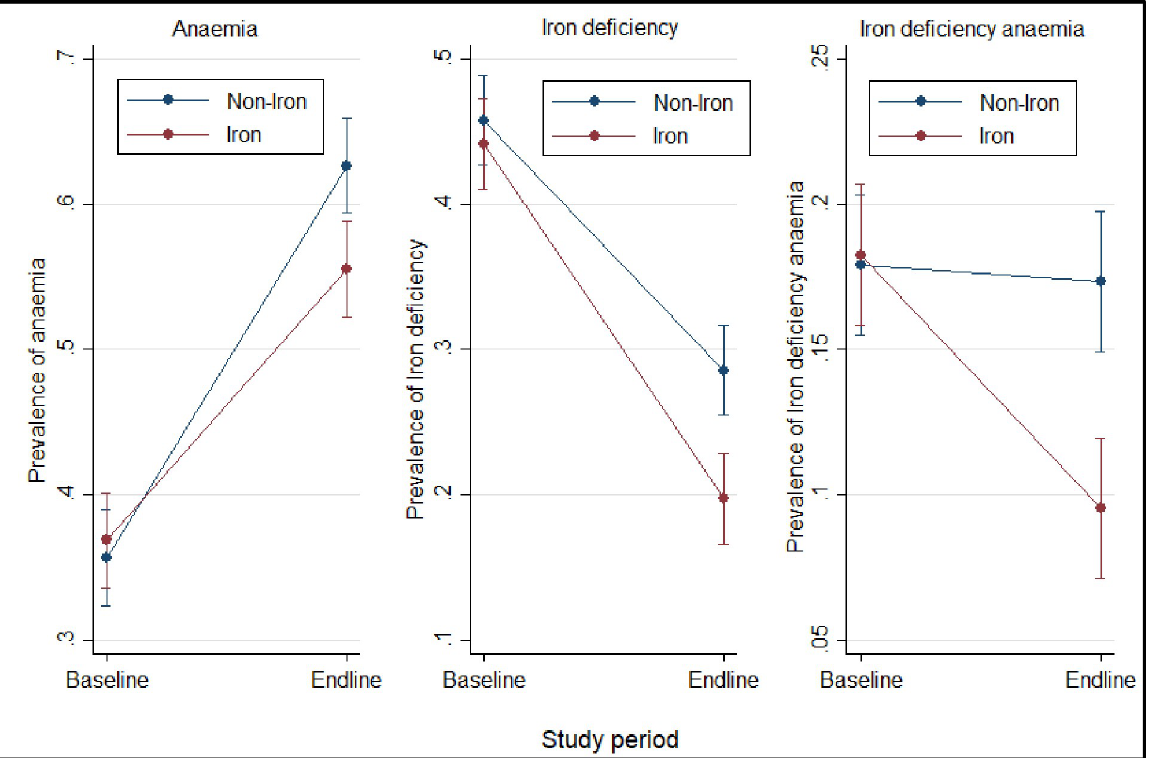
Fig 2. Prevalence of anaemia, iron status between groups at baseline and endline. Plot shows anaemia and iron status prevalence with 95% confidence intervals for each group.